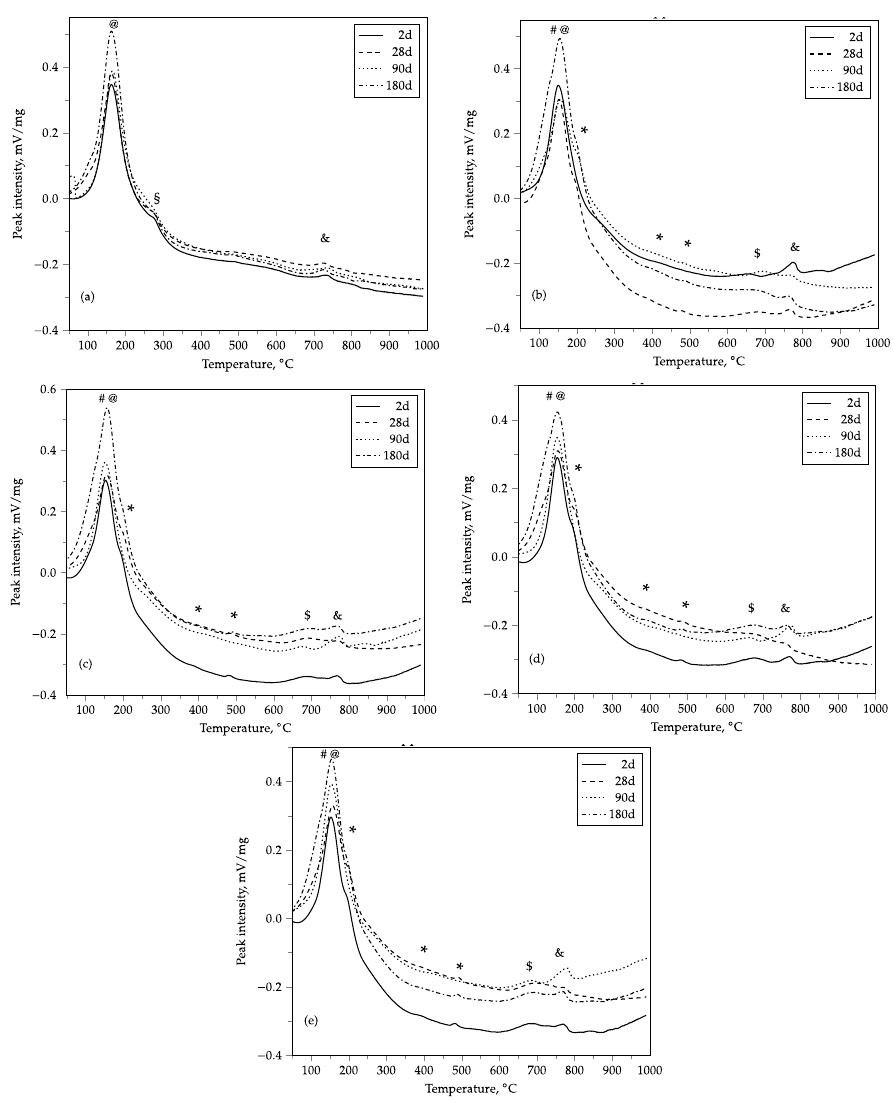
Figure 4. DT for R_C ( a ) R_AI ( b ), R_AC ( c ), R_BI ( d ) and R_BC ( e ) hydrated pastes (w/s = 0.50) for 2, 28, 90 and 180 days. Symbols: # = calcium silicate hydrates/calcium silico (aluminate) hydrates; @ = ettringite; § = aluminum hydroxide; * = hydrotalcite; $ = magnesite (MgCO 3 ); & = calcite. Ettringite, aluminum hydroxide (identified only in R_C), magnesite and calcite were identified by the following fourth dehydration endothermal peaks [59]: 155 °C ± 2 °C, 274 °C ± 15 °C, 682 °C ± 7 °C and 771 °C ± 3 °C. Furthermore, three peaks, related to the H t s, were observed in the CSA-blended cements. C-S-H and C-(A)-S-H, coming from the hydration of the activated slags, were not evident due to the overlapping of the ettringite DT signal. The hydration rates for R_C, R_AI, R_ AC, R_BI and R_BC were also estimated through the calculation of the amount of CBW (Figure 5).